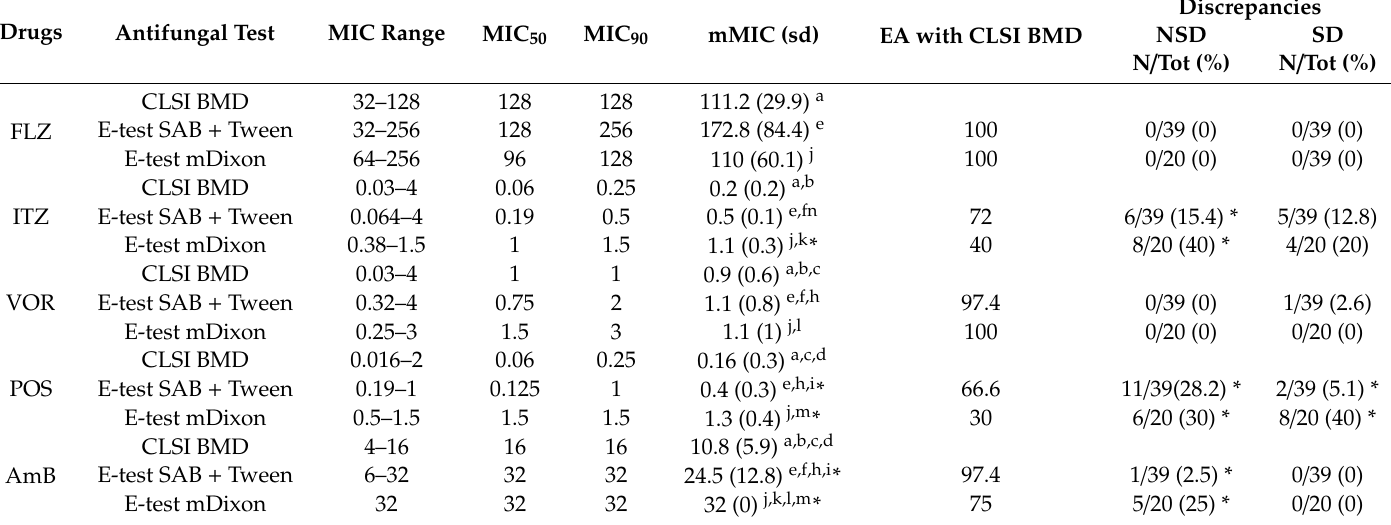
Table 2. Fluconazole (FLZ), itraconazole (ITZ), voriconazole (VOR), posaconazole (POS) and amphotericin B (AmB) minimum inhibitory concentration (MIC; µ g / mL) data after 72 h of incubation obtained with CLSI BMD and E-test in Sabouraud + 1%tween 80 and E-test IN Dixon agar of Malassezia furfur strains from immunocompromised patients with fungemia. Essential agreements (EA) among MIC obtained by E-test compared with CLSI BD methods and discrepancies were also reported.